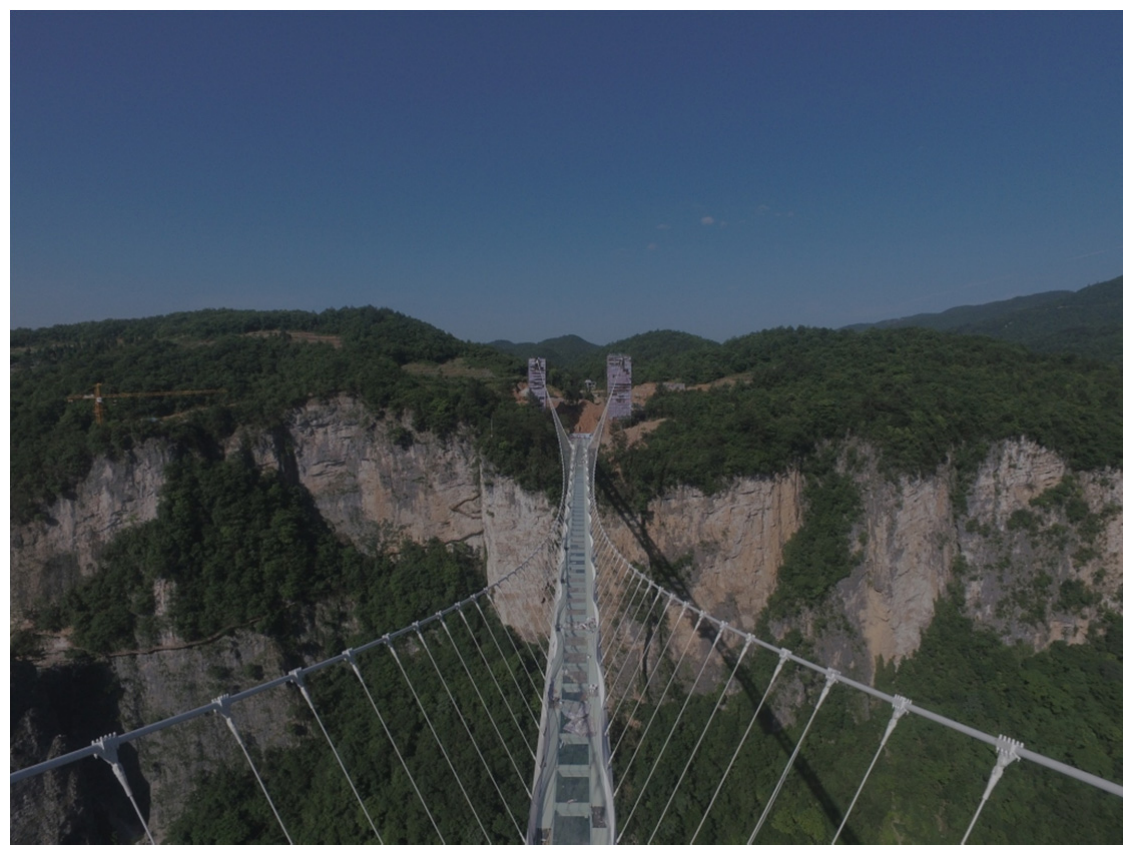
Fig. 5 Zhangjiajie bridge, view over the